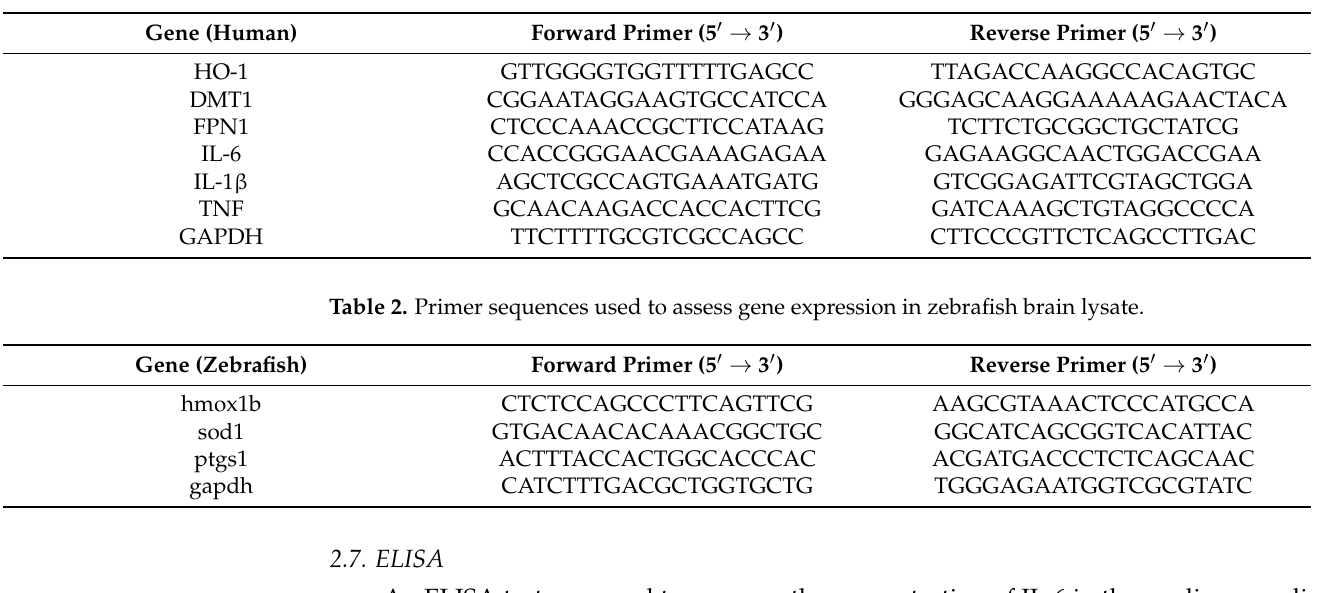
Table 1. Primer sequences used to assess gene expression in human cells.